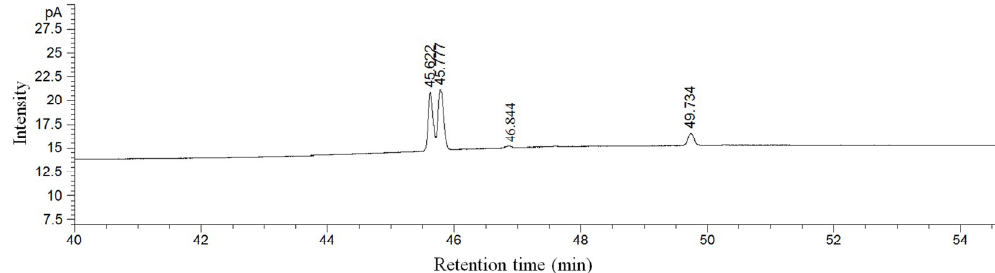
Figure 8. Relative activity of immobilized enzyme in the hydrolysis of p ‐ NPC8 for different cycles.